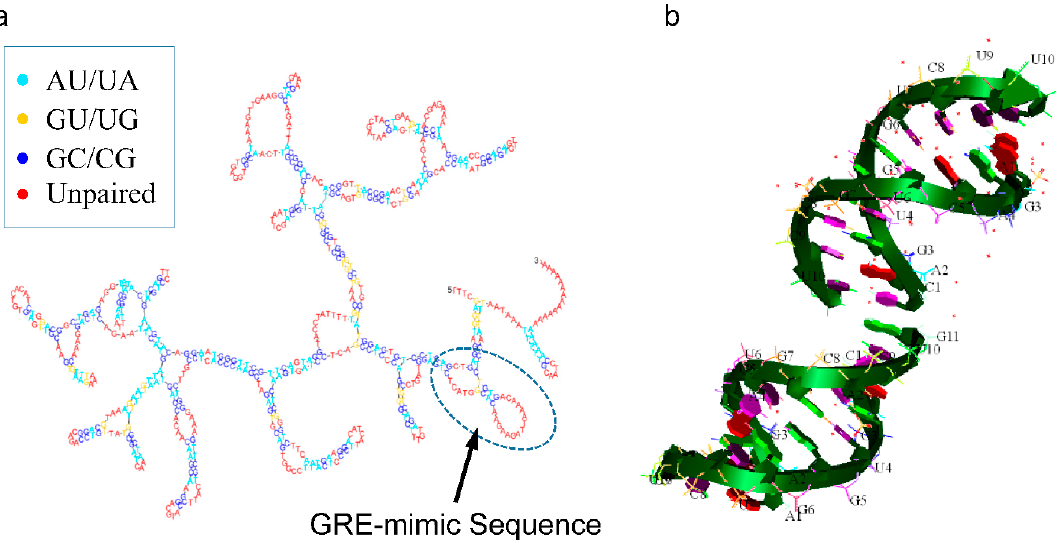
Figure 1. Secondary structure of the growth arrest-specific 5 ( GAS5 ) RNA, showing the glucocorticoid receptor element (GRE)-mimic sequence ( a ), along with the 3D structure of the GRE-mimic sequence ( b ) (the 3D structure of the GRE-mimic was obtained from the Protein Data Bank with reference no. 4MCE [18]).